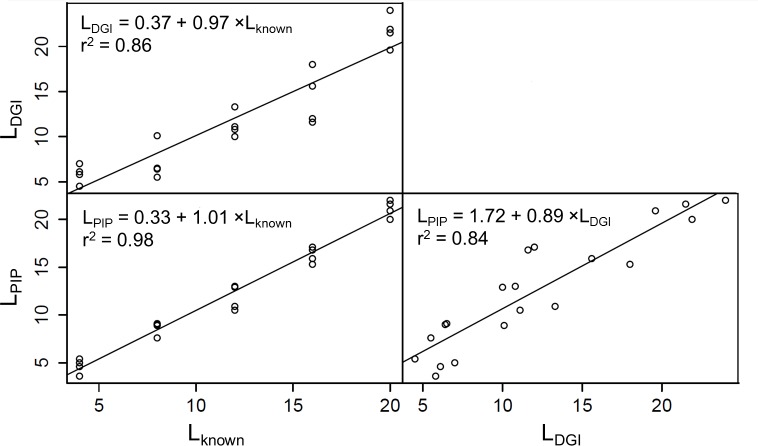
A scatterplot matrix with linear regressions among the lengths of possum fur measured by both the DGI (LDGI) and PIP (LPIP) methods and the known lengths of possum fur (Lknown).